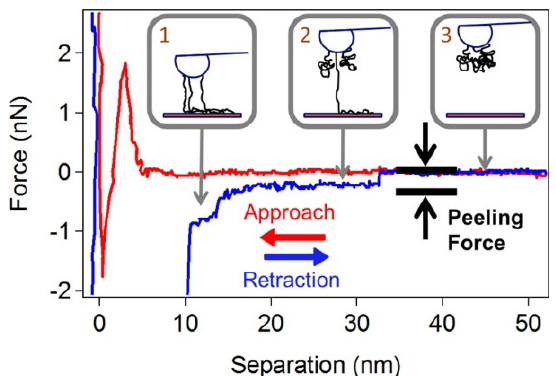
Figure 4. A typical force curve during the peeling of a T 100 ssDNA molecule away from a SWNT surface, demonstrated by Iliafar et al. (Reprinted from reference [83] with